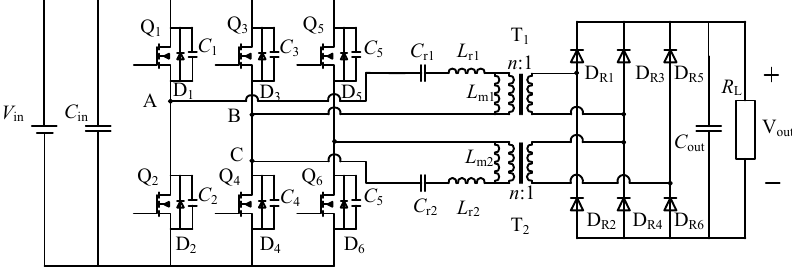
Figure 2. New wide output resonant converter circuit diagram.